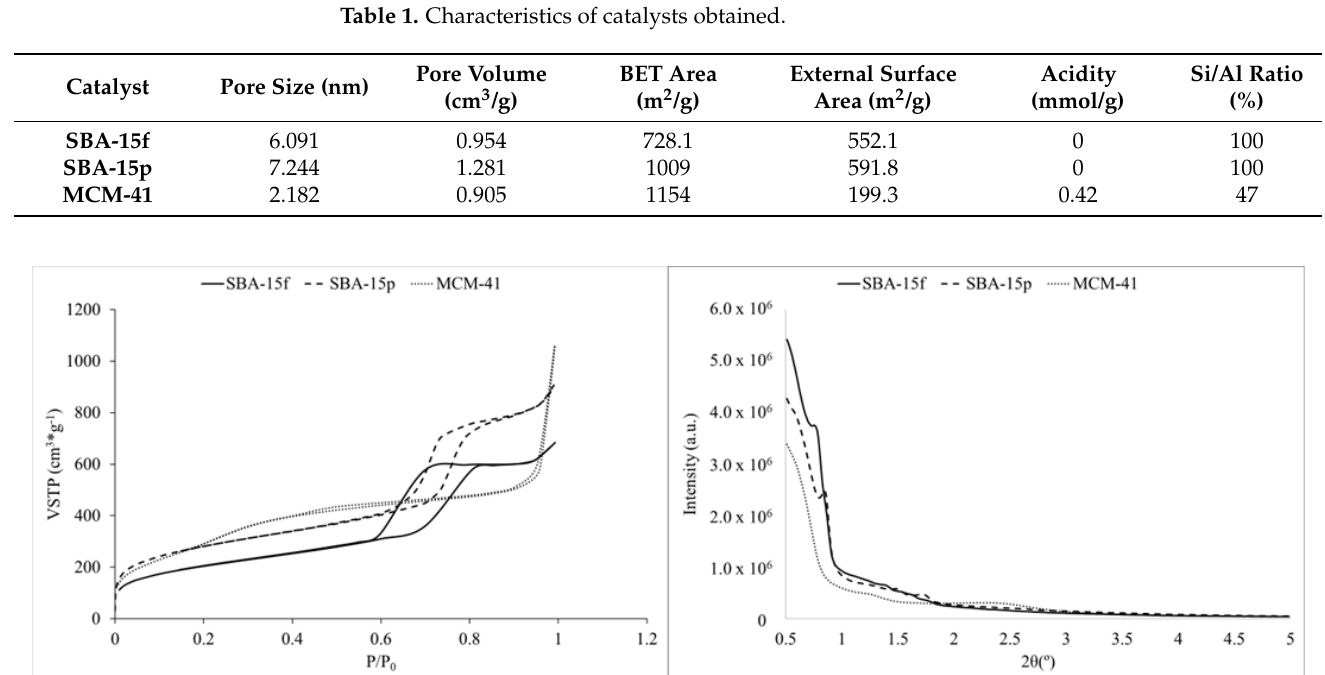
Figure 1. 77 K N 2 adsorption isotherms ( left ) and diffractograms ( right ) of the three catalysts obtained.